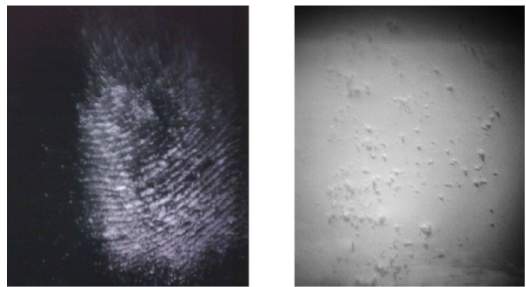
Figure 6. Traces of RDX left by a fingerprint and observed by the internal camera at a target at a distance of 10 m: left , on black polypropylene; right , on white varnished metal. 10 m: left , on black polypropylene; right , on white varnished metal.